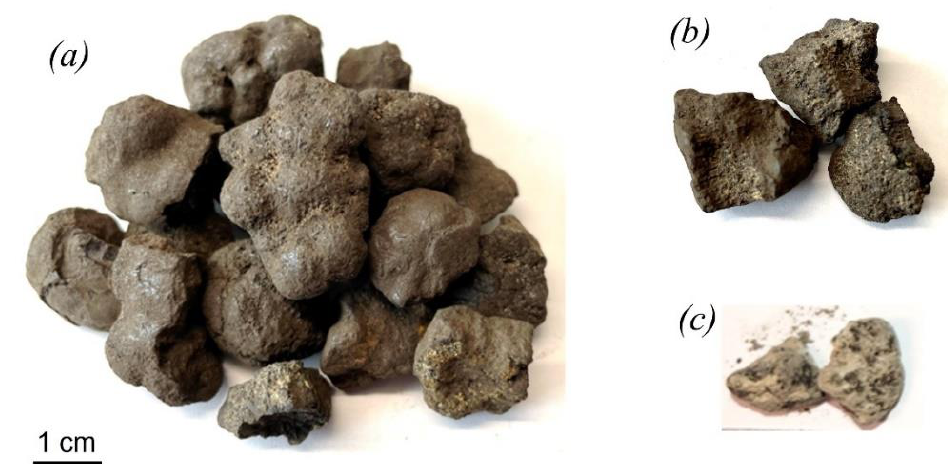
Figure 1. ( a , b ) Visual illustration of the received PMMN particles, and ( c ) separated bright particles. Table 2. XRF analysis from supplier and measurements in this